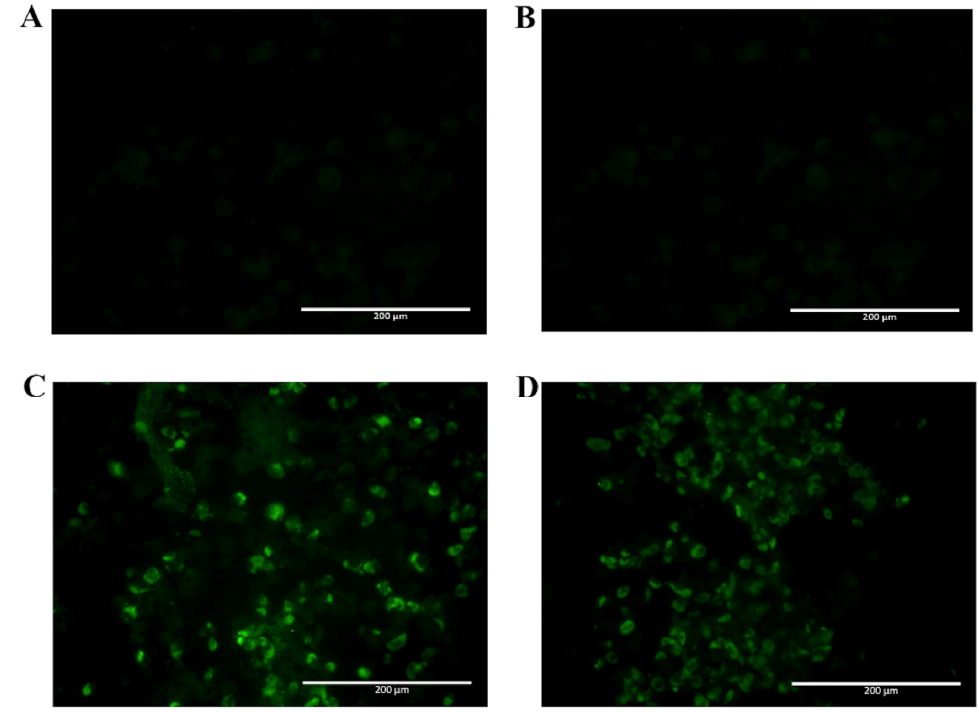
Figure 6. Reactivity of NS1 ‐ specific mAbs to zika virus ‐ infected Vero cells. Cells were infected with a MOI of 0.05. 72 h post infection, cells were fixed, permeabilized and treated with each of the tested mAbs. Then, cells were labeled with FITC ‐ conjugated goat ‐ anti mouse IgG. Tested mAbs: ( A ) 4F6, ( B ) 4H2, ( C ) 2H5 and ( D ) 4H1BC. Magnification of 200×.